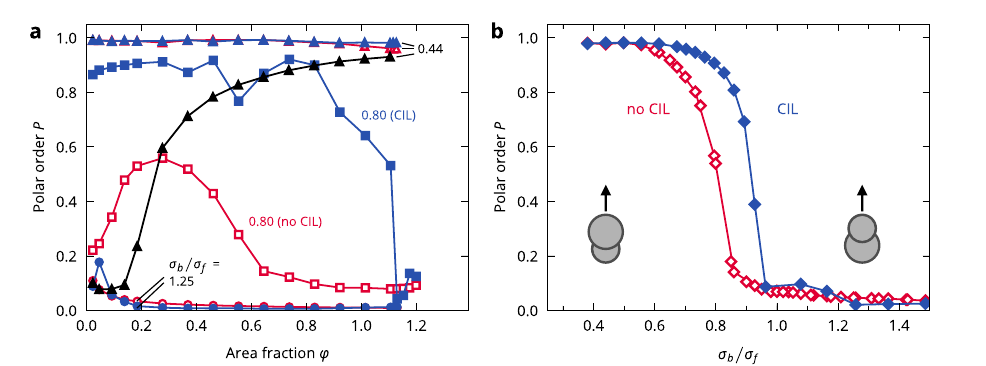
Figure 3. Cell speeds. ( a ) Average cell speed, normalized by the steady-state speed of a solitary cell v ss , with (closed symbols) and without (open symbols) contact inhibition for a range of cell shapes. ( b ) Speed of MDCK cells in a growing cell colony (extracted from ref. 22) and in confluent monolayers (extracted from refs 46, 47). ( c ) Speed histograms at σ b / σ f = 0.80. Black lines are fit to the data with a log-normal distribution.